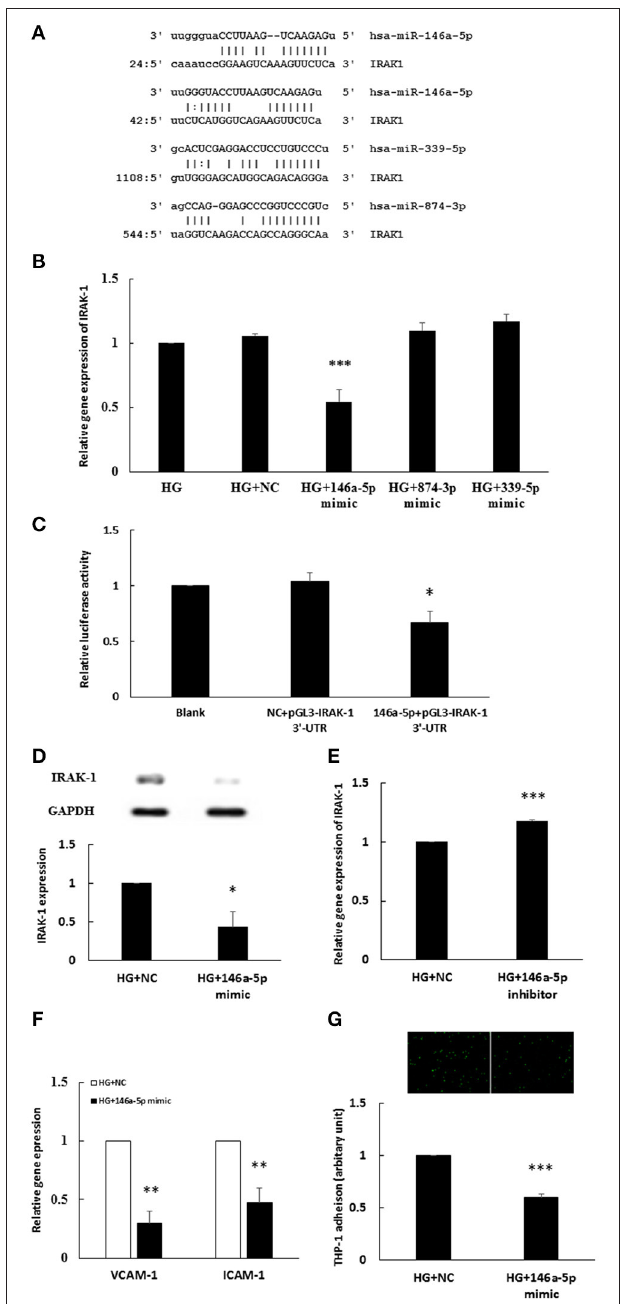
FIGURE 3 | (A–G) The miR-146a-5p mimic inhibited HG-induced endothelial IRAK-1 expression and inflammatory phenotypes. (A) Bioinformatic miR target analysis identified homologies between miR-146a-5p (two binding sites), miR-339-5p, miR-874-3p, and the 3 ′ -UTR of human IRAK-1 mRNA, indicating potential regulation of IRAK-1 by these three miRs. (B) Three miR mimic competition assays determined that the stimulatory effect of HG on IRAK-1 mRNA expression was inhibited only in miR-146a-5p mimic-transfected HAECs. n = 4. *** p < 0.001, as compared with HG treatment transfected with a negative control (HG + NC) (ANOVA). (C) A luciferase reporter assay showed that the miR-146a-5p mimic could downregulate the relative luciferase activity of pGL3-IRAK-1 3 ′ -UTR. n = 5, * p < 0.05, compared with the negative